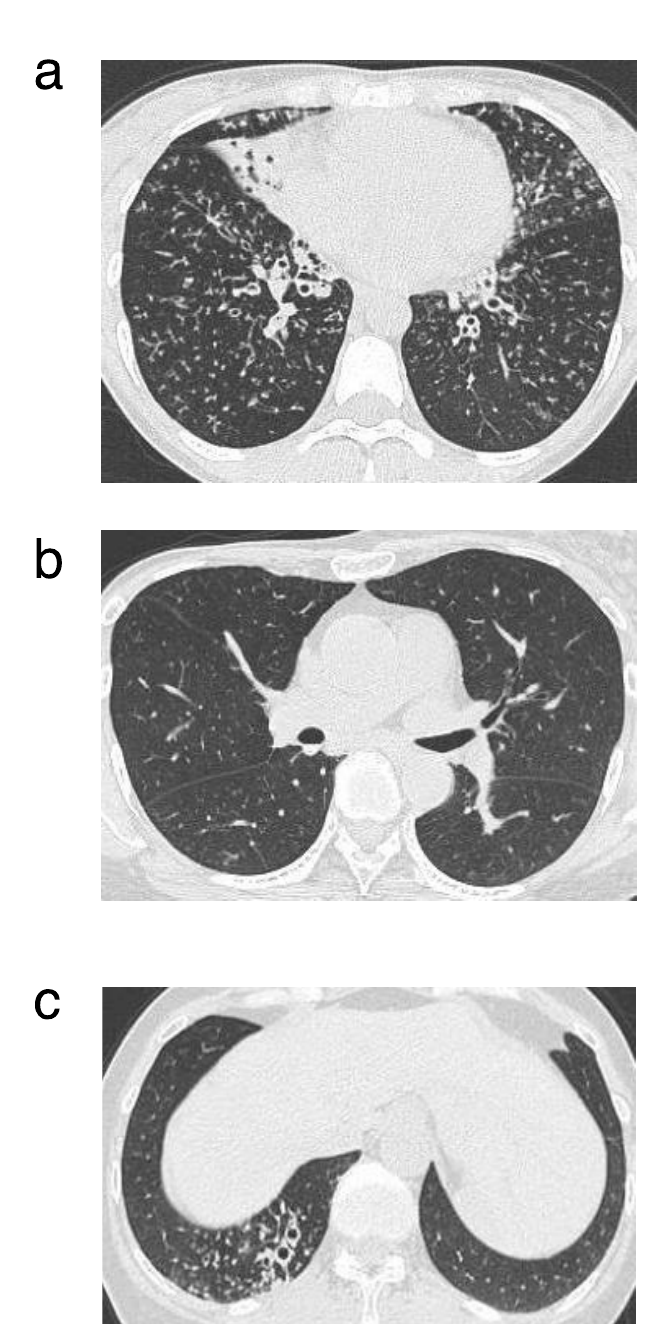
Figure 3. Chest computed tomography (CT) findings of the typical clinical cases from the low- and high-tolerance groups. The chest CT from the low- tolerance group showed only right lower lobe bronchiectasis and small nodules in 2012. The other lobes were normal ( a , b ). The chest CT from the high-tolerance group showed diffused small rounded and linear opacities, dilation of small bronchi, and bronchial wall thickenings in 2009. It was predominantly located in the lower lobe ( c ).